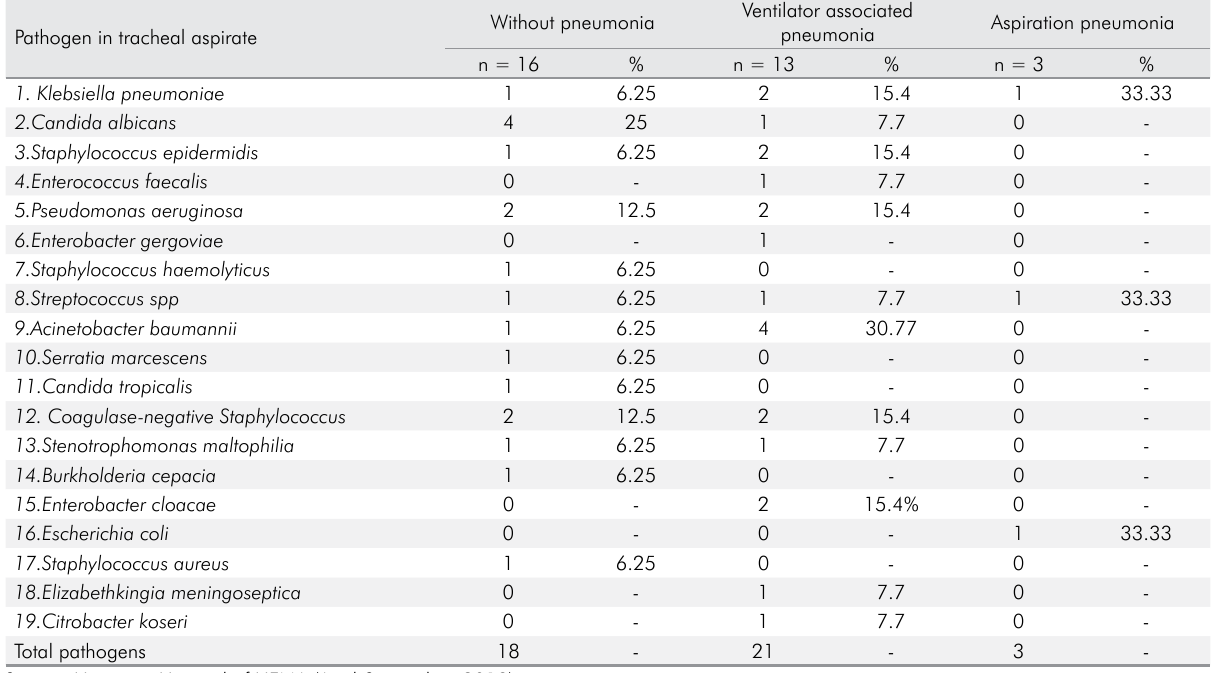
Table 1. Distribution of pathogens identified in the tracheal aspirate of mechanically ventilated patients in the adult intensive care unit according to the pulmonology evolution of the